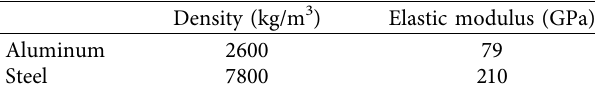
Figure 17: Voltages and currents of PSPS with different cell numbers. (a) Required voltages of the piezoelectric stacks under active control. (b) Required currents of the piezoelectric stacks under active control. Table 3: Parameters of aluminum and